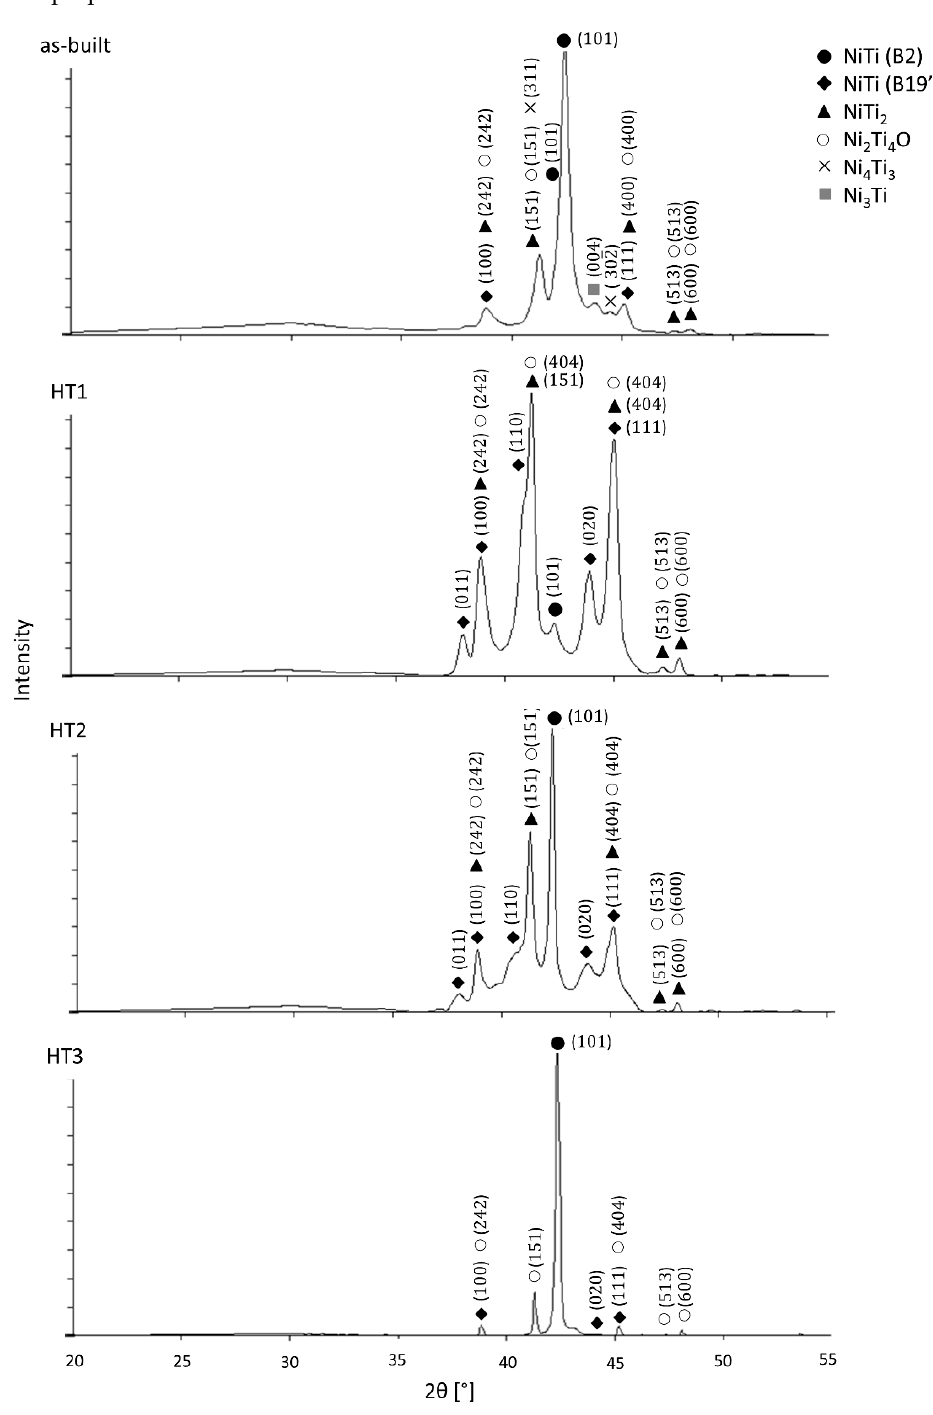
Figure 3. XRD diffractograms of as-built and HT1 (1000 °C/10 h), HT2 (900 °C/24 h), and HT3 (900 °C/24 h + 1150 °C/24 h) heat-treated samples.